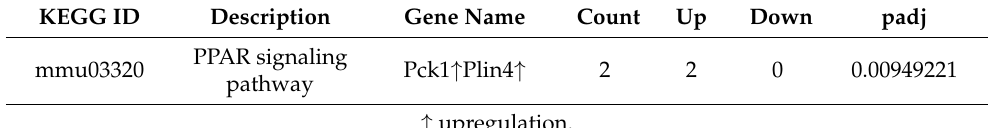
Table 3. List of pathway enriched with splenic DEGs (padj <